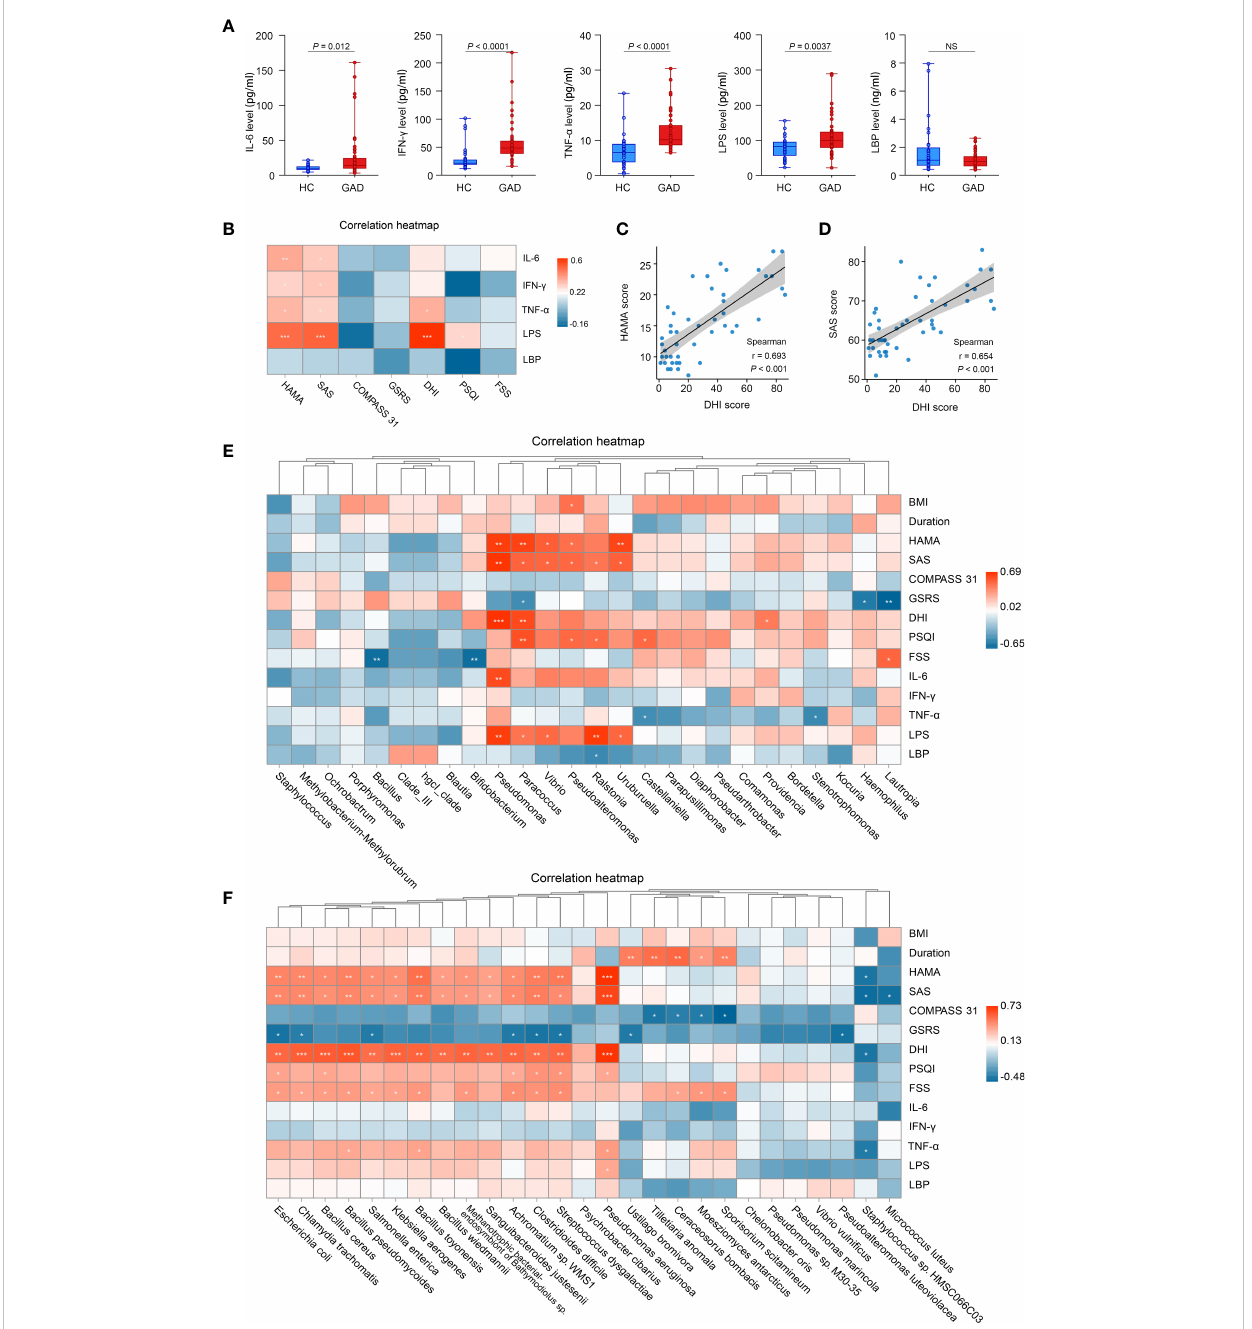
FIGURE 3 Altered systemic in fl ammatory cytokines in GAD patients and the correlations between clinical symptoms and abundances of taxonomic differences of ear canal microbiota. (A) Comparison of systemic in fl ammatory biomarker levels (IL-6, IFN- g , TNF- a , LPS, and LBP) from serum samples in GAD and HC groups. Results are expressed as median and range. (B) Heatmap showing Spearman ’ s correlation between clinical parameters and in fl ammatory cytokines between groups. Red denotes positive correlation and blue denotes negative correlation. (C) Spearman ’ s correlation between the DHI score and HAMA score. (D) Spearman ’ s correlation between the DHI score and SAS score. (E) Heatmap showing Spearman ’ s correlation between clinical parameters and differentially abundant genus between groups. Red denotes positive correlation and blue denotes negative correlation. (F) Heatmap showing Spearman ’ s correlation between clinical parameters and differentially abundant species between groups. Red denotes positive correlation and blue denotes negative correlation.* P < 0.05, ** P < 0.01, and *** P < 0.001; IL-6, interleukin-6; TNF- a , tumor necrosis factor- a ; IFN- g , interferon- g ; LPS, lipopolysaccharide; LBP, lipopolysaccharide-binding protein; HAMA, Hamilton Anxiety Scale; SAS, the self- rating anxiety scale; COMPASS 31, Composite Autonomic Symptom Score 31; GSRS, Gastrointestinal Symptom Rating Scale; DHI, Dizziness Handicap Inventory; PSQI, The Pittsburgh sleep quality index; FSS, Fatigue Severity Scale. NS P ≥